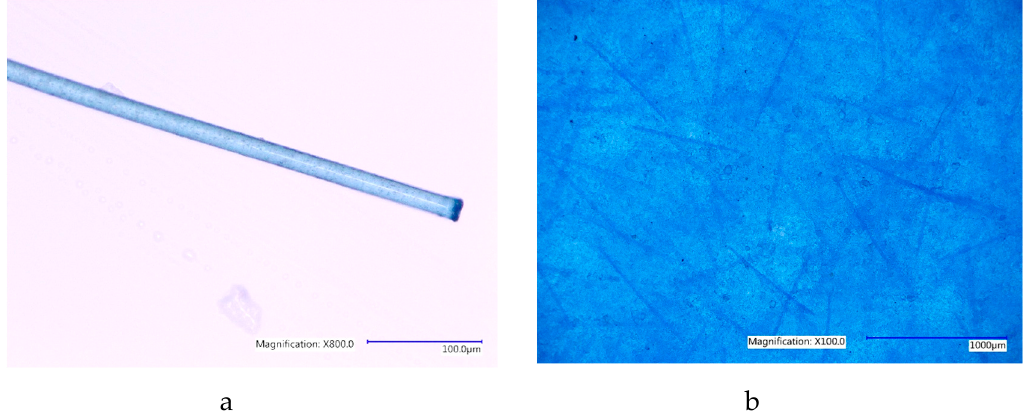
Figure 6. ( a ) The fibre type used in all tests shown here at ×800 magnification. The burred, cut-edge visible in the image suggests the fibres were cut with a hot blade during manufacture. ( b ). Prepared elastomeric specimen PDMS A-10 with 2% fibre saturation at ×100 magnification. Note also the even dispersion of fibres throughout the specimen without clumping of fibres.